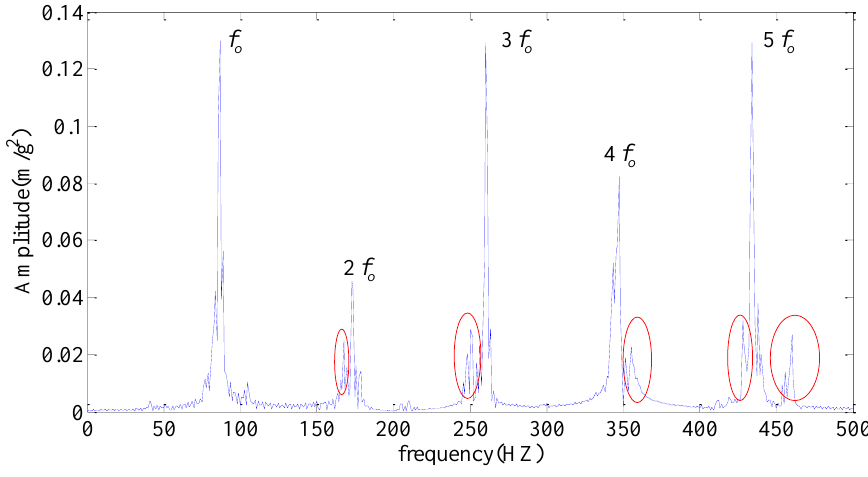
Figure 8. Frequency spectrum of WPT.